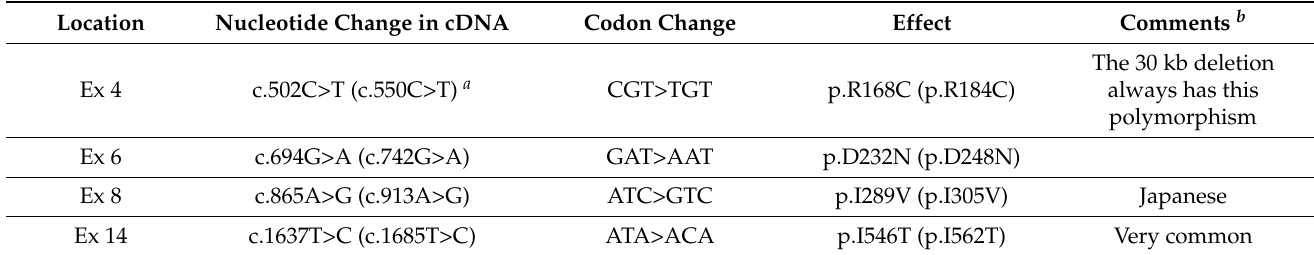
Table 2. Common Polymorphic Variants in the GALC